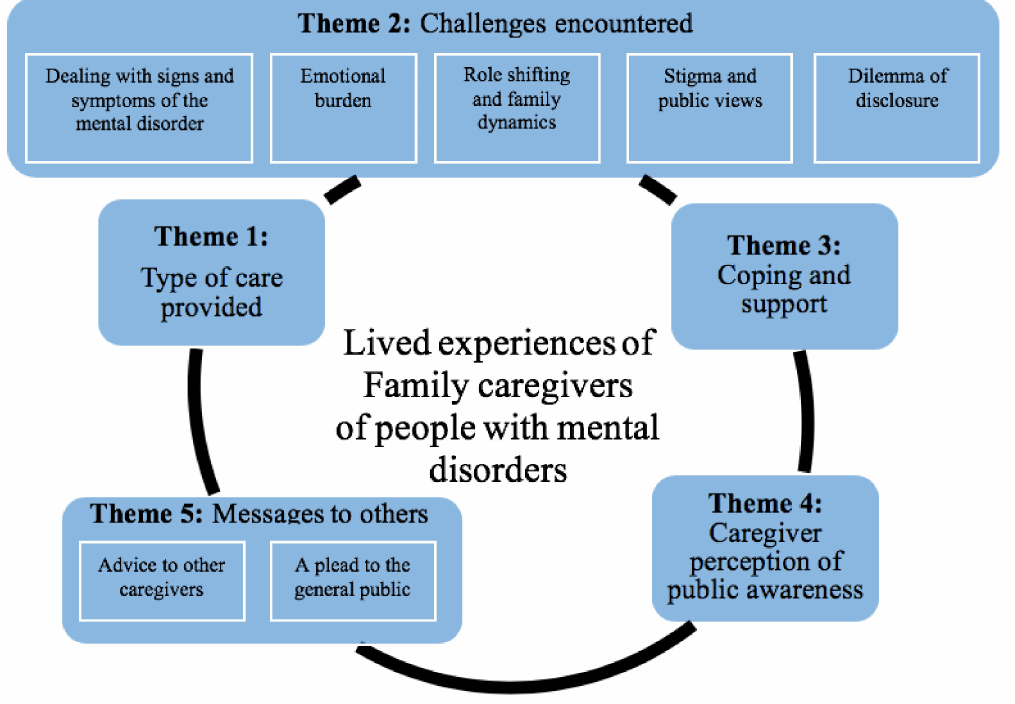
Figure 1. Diagrammatic representation of the main and sub-themes found in this